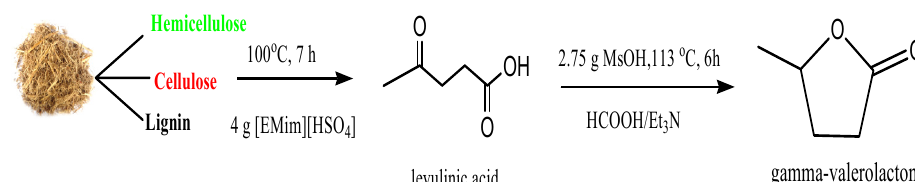
Figure 1. GVL production from LA derived from DSB.